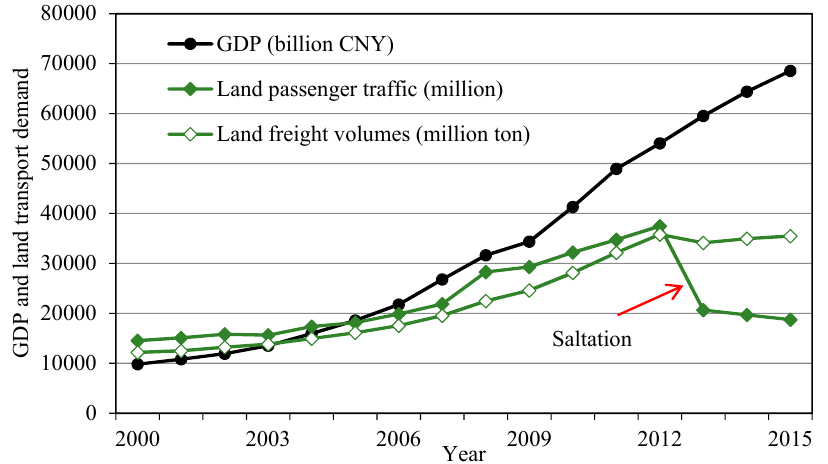
Figure 2. GDP and land transportation at the national level in China, 2000–2015. (Source, NBSC <www.stats.gov.cn>).